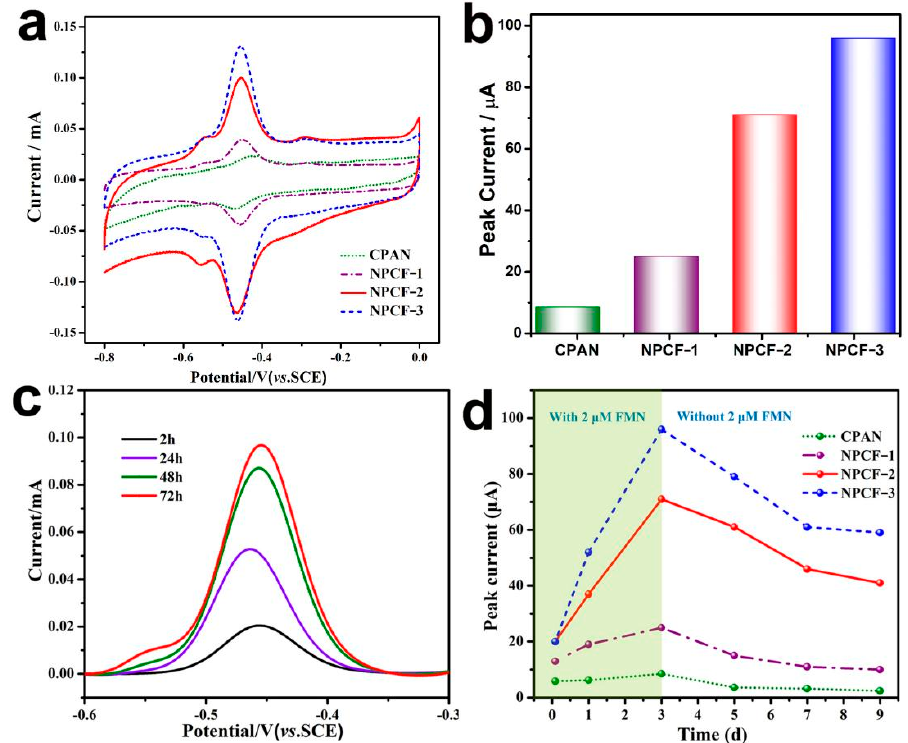
Figure 3. ( a ) CVs at the scan rate of 5 mv s − 1 and ( b ) Peak current values of different carbon fiber electrodes in 0.1 M PBS buffer with 2 μ M FMN, ( c ) the oxidative peak of NPCF-3 at a different time electrodes in 0.1 M PBS buffer with 2 µ M FMN, ( c ) the oxidative peak of NPCF-3 at a different time in in 0.1 M PBS buffer with 2 μ M FMN and subsequent transfer to 0.01 M PBS buffer, ( d ) time- 0.1 M PBS buffer with 2 µ M FMN and subsequent transfer to 0.01 M PBS buffer, ( d ) time-dependent dependent peak current variation of different carbon fiber electrodes. peak current variation of different carbon fiber